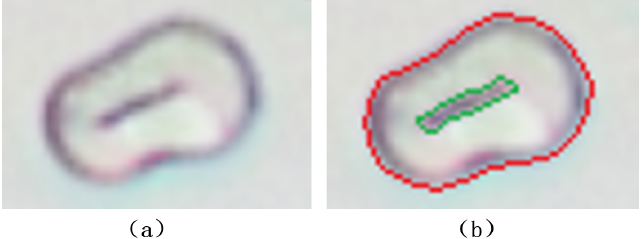
Figure 2. Cross-section and edge of cotton fiber. ( a ) Microscopic image of a cotton fiber cross-section. ( b ) Edge of